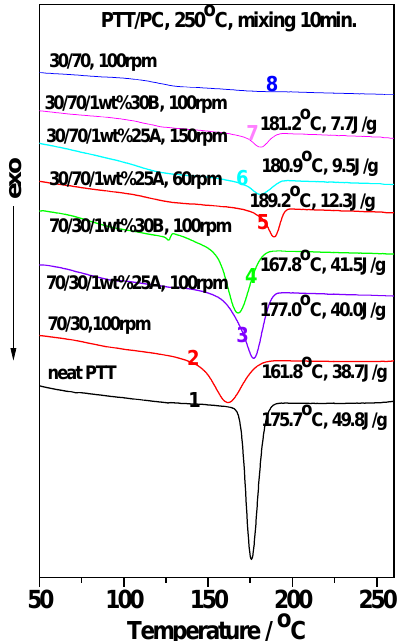
Figure 1. Influence of the surface hydrophobicity of montmorillonite (MMT) (Cloisite ® 25A and Cloisite ® 30B) on the crystallization behavior of poly(trimethylene terephthalate)/polycarbonate (PTT/PC) blends. The peak crystallization temperature T c and the apparent crystallization enthalpy ΔH c are shown.